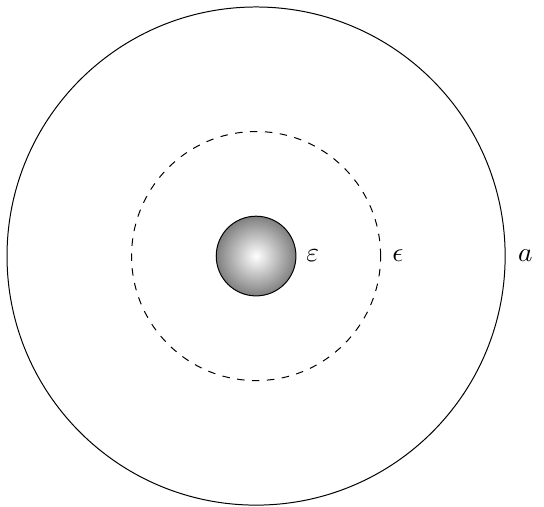
Figure 1 . A schematic of the scales arising when relating near-source boundary conditions to the source action. We denote by " the actual UV scale associated with the size of the source (e.g., the size of the proton), which we assume is very small compared to the scale a of physical interest (e.g., the size of an atom). The PPEFT uses the action of the point source to set up boundary